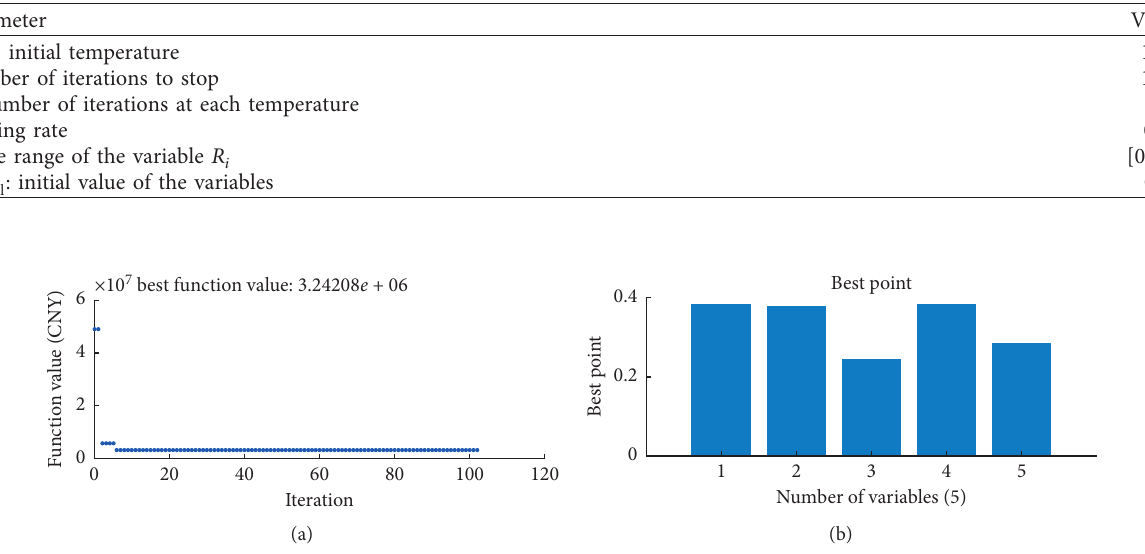
Table 3: SA parameters.